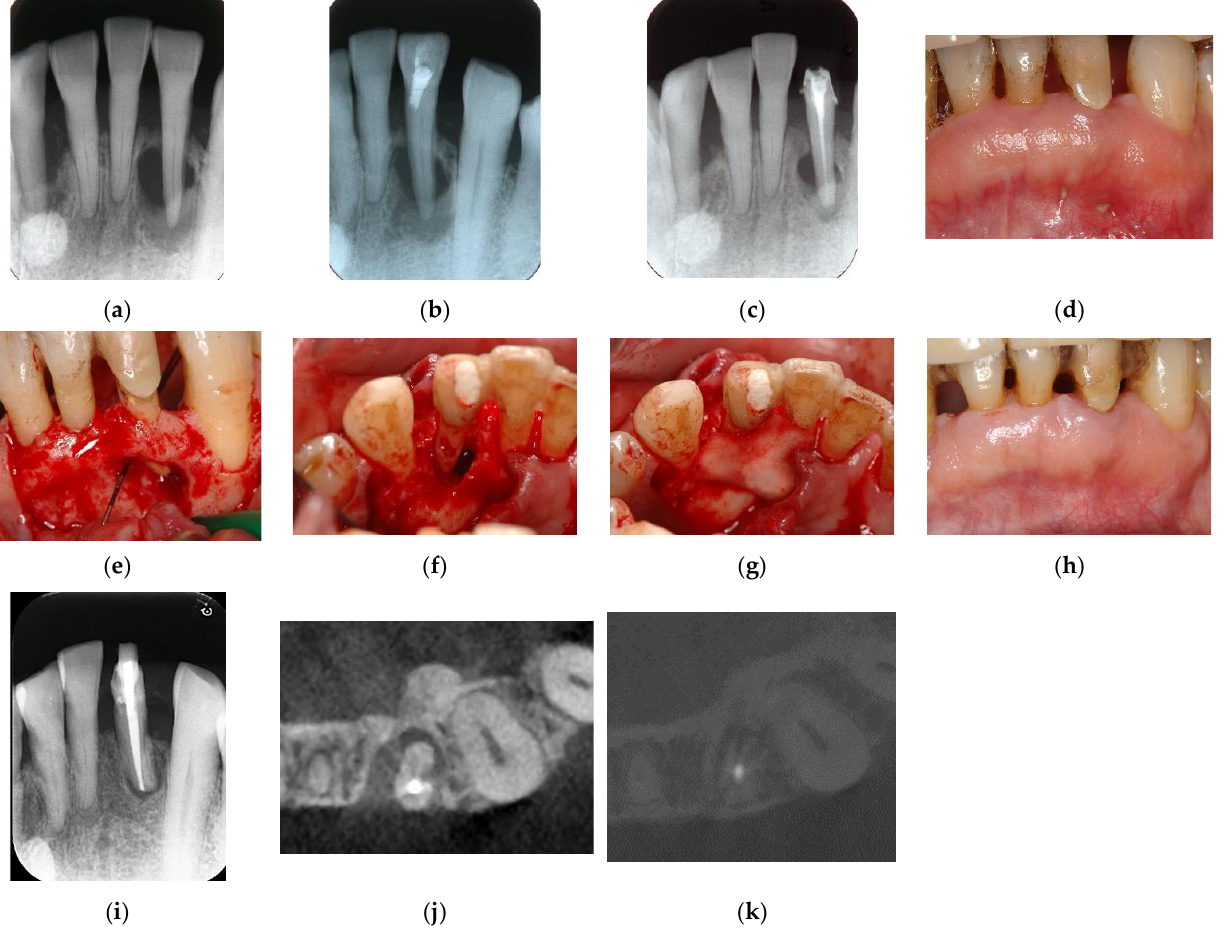
Figure 7. Clinical case 6. Male, age 58 yrs. ( a ) Preoperative periapical radiograph of the lower left incisor at baseline, showing the “bone” defect as a radiolucent area around the root. ( b ) Iatrogenic perforation during a previous dental procedure. ( c ) Postoperative periapical radiographs of the root canal treatment and a broken instrument. ( d ) Intraoral view 3 years after poor endodontic treatment, showing a fistula at the apical site of the tooth. ( e , f ) Flap retraction and debriding of the defect at both the labial and lingual sites, showing expansive bone resorption. ( g ) GTR treatment with resorbable membranes at both the labial and lingual sites. ( h ) Follow-up intraoral finding 10 years later, showing healthy gingiva. ( i ) Follow-up periapical radiograph 10 years after surgery. ( j , k ) Preoperative CBCT and follow-up CBCT after 10 years, showing periodontal tissue regeneration.